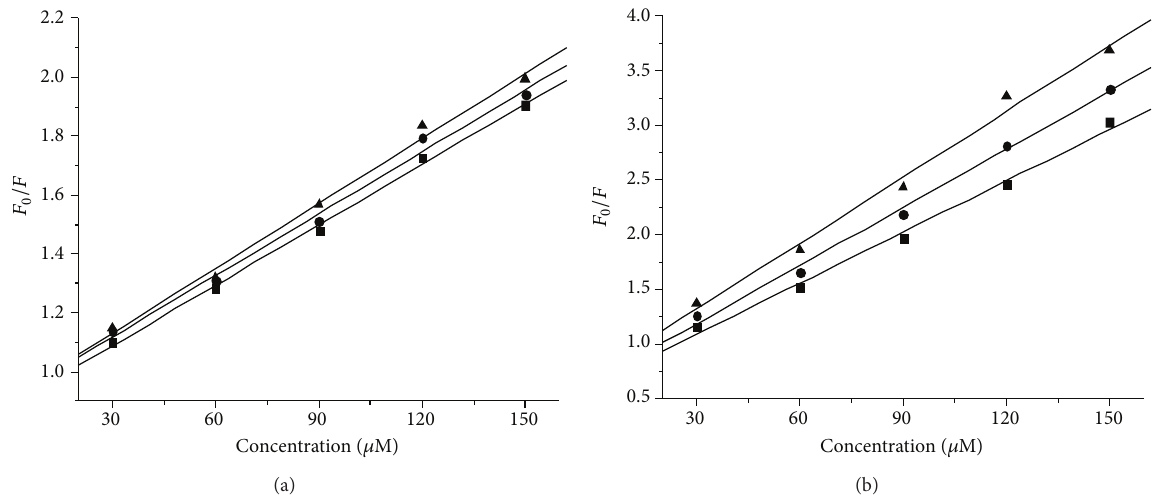
Figure 4: Stern-Volmer plots for the fluorescence quenching of DNA-EB system by ligand L (a) and La (III) complex (b) at different temperatures, ( 󳵳 ) 298 K; ( e ) 303 K; ( ◼ ), 310